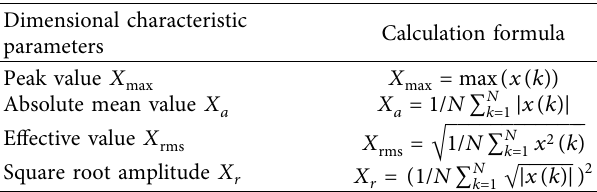
Figure 8: Simulation signal of the bearing inner ring fault model in (a) time domain and (b) frequency domain. Table 2: Calculation formulas of dimensional characteristic